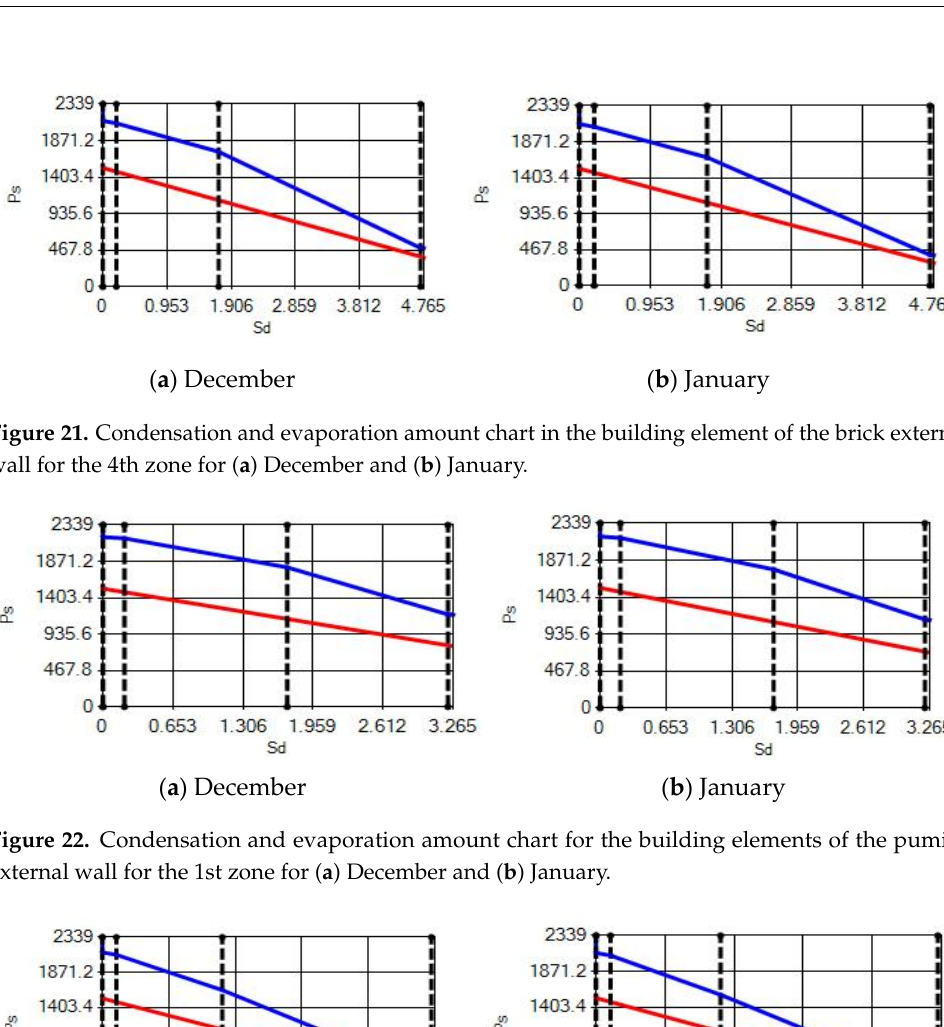
Figure 22. Condensation and evaporation amount chart for the building elements of the pumice external wall for the 1st zone for ( a ) December and ( b ) January.